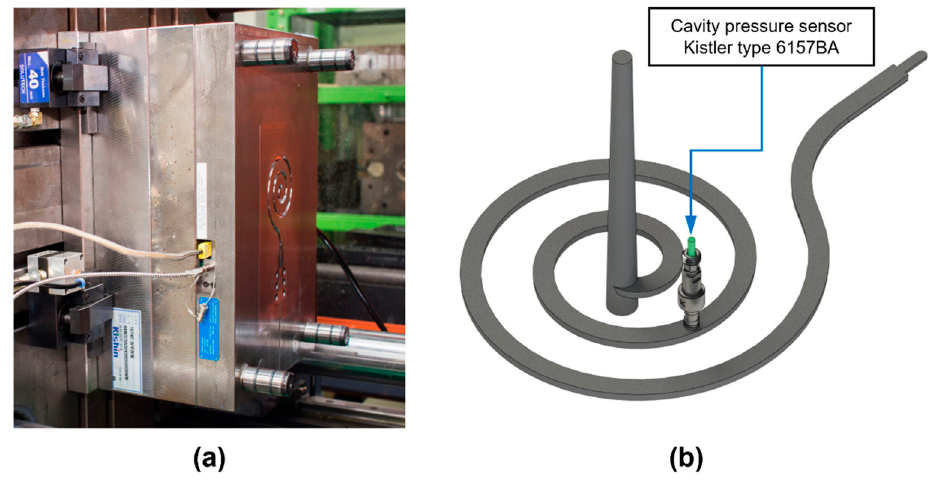
Figure 3. Injection mold setup ( a ) moving plate of spiral mold, and ( b ) cavity geometry and pressure sensor position.